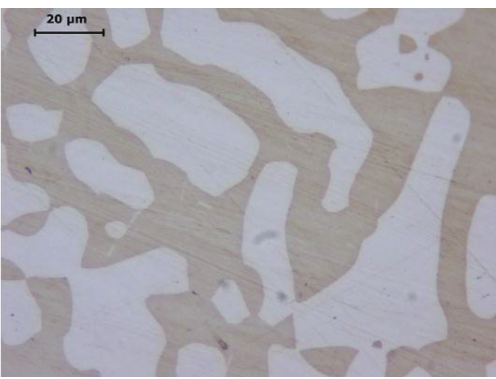
Figure 1: Microstructure of DSS, solution annealed at 1050 ◦ C for 1 hour (austenite in white, ferrite in gray).